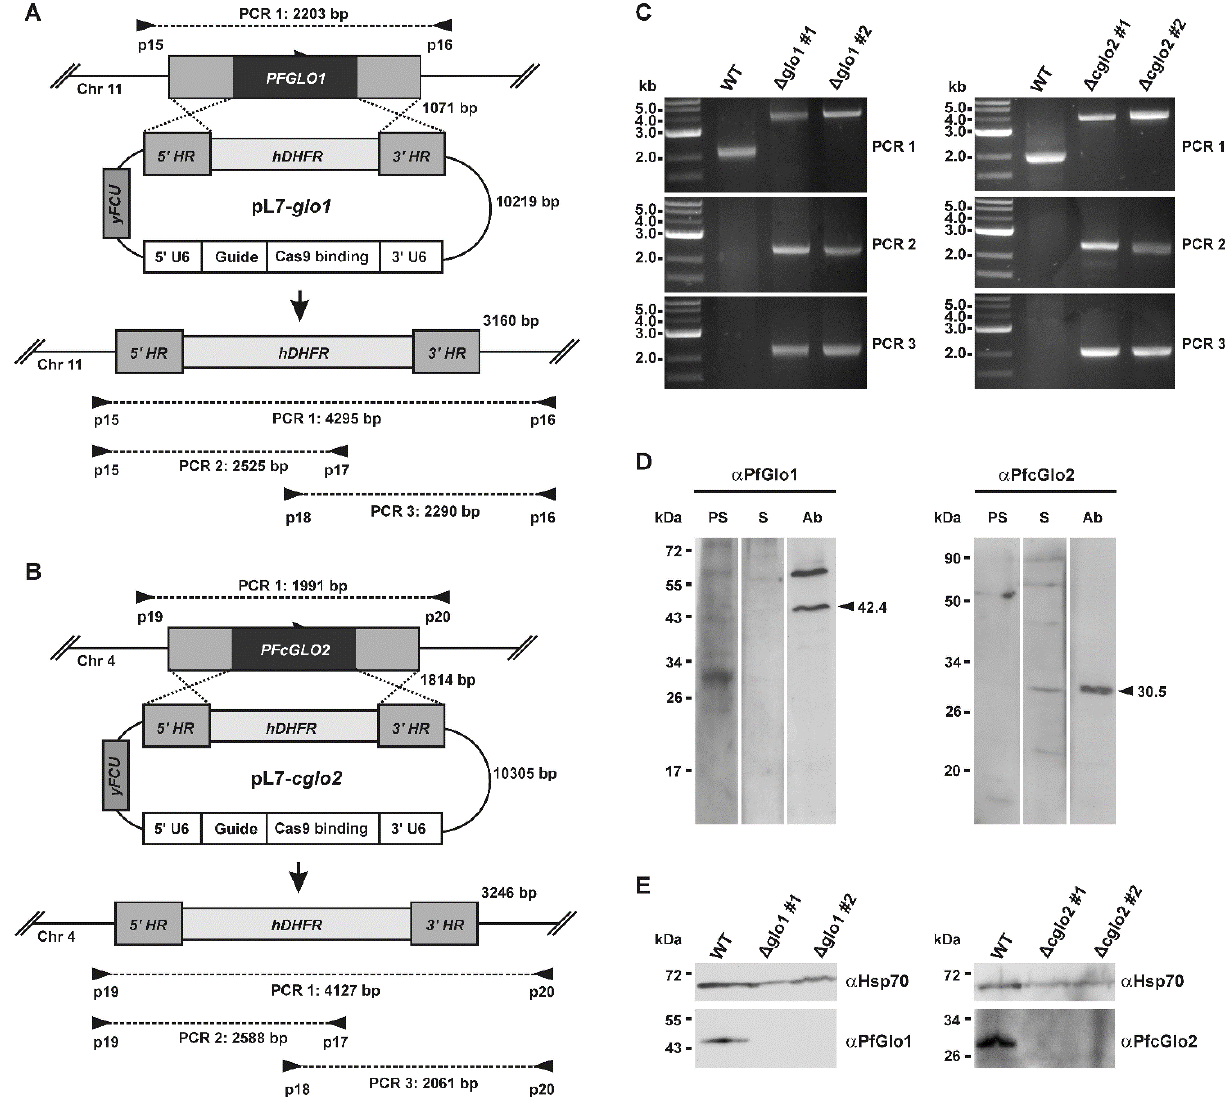
FIGURE 1: Generation and validation of P. falciparum 3D7Δglo1 and 3D7Δcglo2 knockout strains. (A) and (B) Knockout strategy for PFGLO1 and PFcGLO2 using the CRISPR-Cas9 system based on the method by Ghorbal et al . [29]. Primer pairs and expected PCR products 1-3 for wild-type strain 3D7 and knockout parasite lines are indicated. (C) PCR controls with isolated genomic DNA from clonal parasite lines 3D7Δglo1 and 3D7Δcglo2 after transfection, selection and limited dilution. PCR products 1-3 are shown for two clones (#1 and #2) from each knockout experiment. Wild-type strain 3D7 served as a control. (D) Analysis of rabbit peptide antibodies against PfGlo1 and PfcGlo2. P. falci- parum extracts from 2 x 10 7 cells were loaded per lane on a 15% gel, separated by reducing SDS-PAGE and analyzed by western blotting. The expected sizes of PfGlo1 and PfcGlo2 are indicated by arrowheads. PS, S, Ab: Decoration with pre-immune serum, serum and affinity-purified antibody, respectively. (E) Western blot controls with extracts from wild-type strain 3D7 as well as two clonal 3D7Δglo1 and 3D7Δcglo2 para- site lines from panel C using the purified antibodies from panel D. Decoration with an antibody against Hsp70 served as a loading